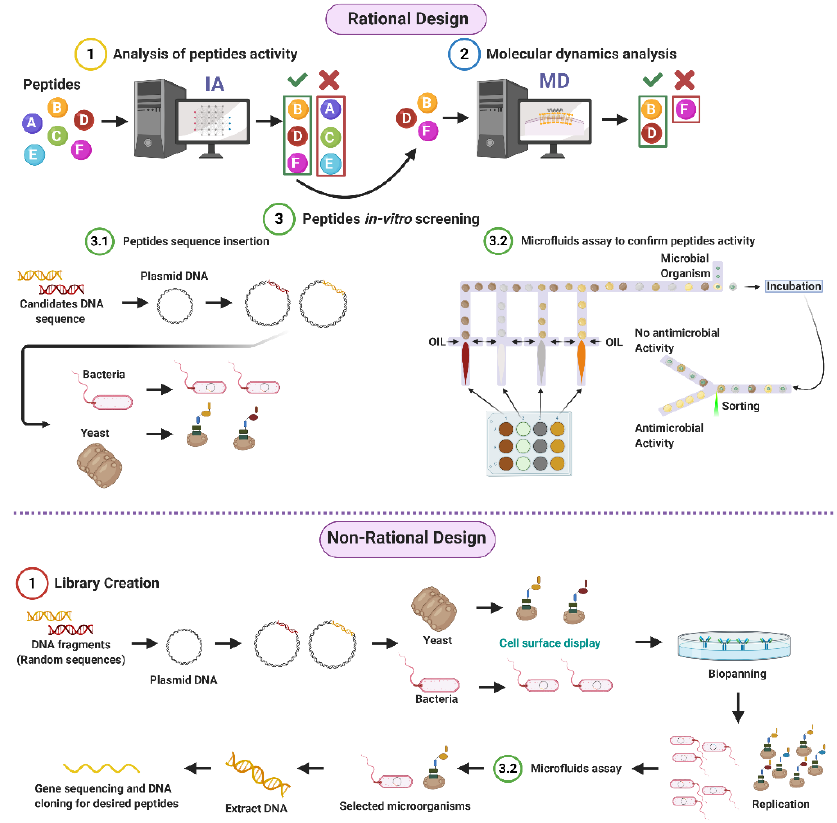
Figure 1. Antimicrobial Peptides (AMPs) discovery framework. Rational design steps: (I) Deep learning techniques identify sequences with potential antimicrobial activity, (II) membrane-disruption capabilities of selected sequences are analyzed via molecular dynamics (MD), (III) the host cell is modified, and sequences are inserted, finally (IV) antimicrobial activity is corroborated by a microfluidic system. Non-rational design steps: (I) Random sequences are expressed on host cells through cell surface display, (II) modified microorganisms are analyzed by a microfluidics system to obtain AMPs candidates, and (III) DNA is extracted, sequenced, and cloned (Created with BioRender).